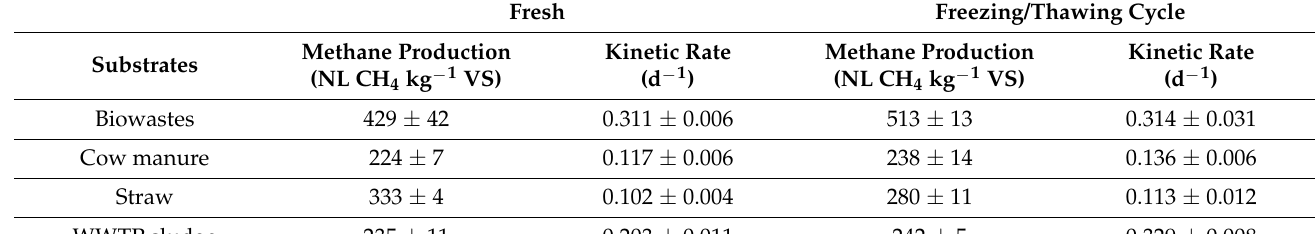
Table 5. Influence of the freezing/thawing process on biogas production and kinetics.